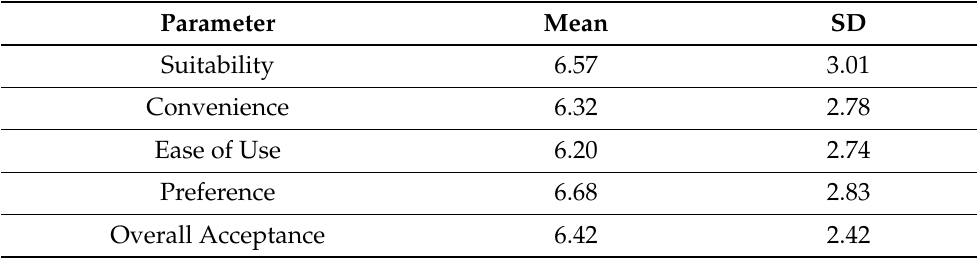
Table 2. The acceptance of screening instruments on a bipolar likert-scale ranging from 1 (bad) to 10